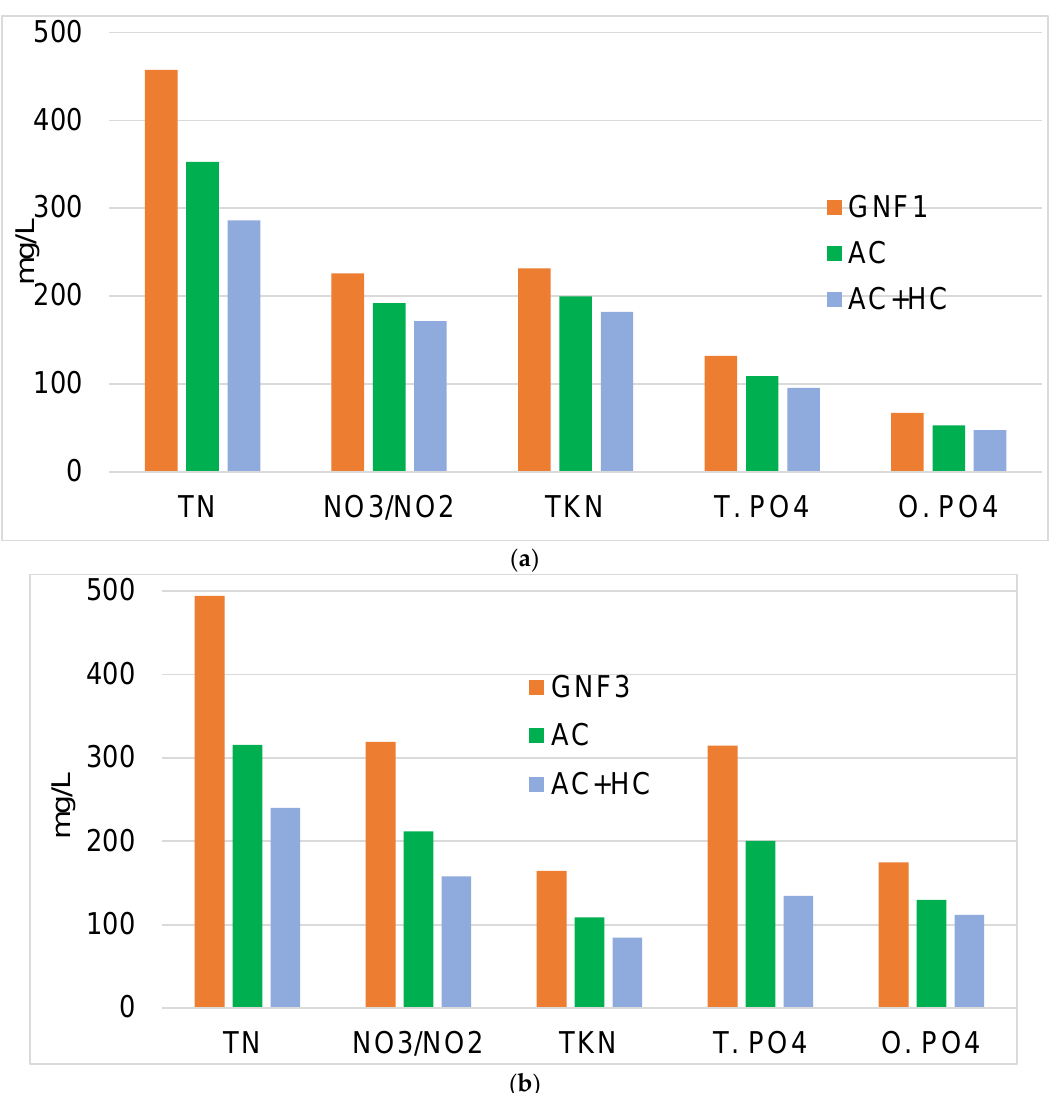
Figure 5. ( a ) Nutrients in GNF1 and removal by AC and AC+HC. ( b ) Nutrients in GNF3 and removal by AC and AC+HC.